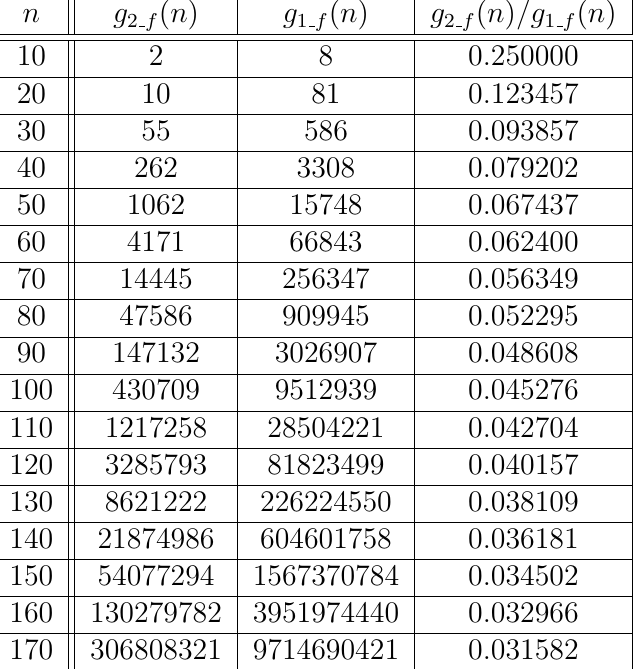
Table 7: Number of forcibly biconnected graphical partitions of n and their proportions in all forcibly connected graphical partitions of n